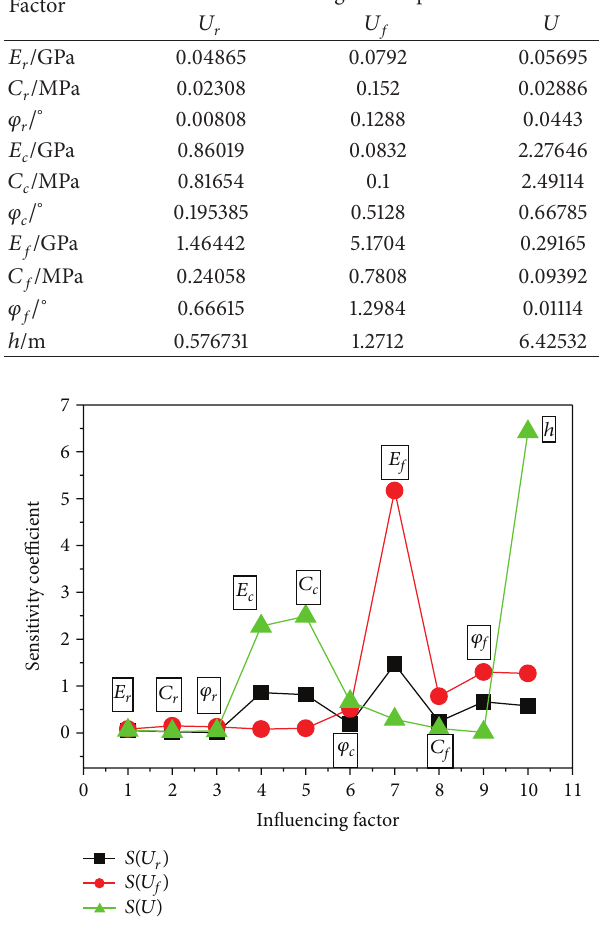
Figure 5: Comparison of various sensitivity coefficients for influ- encing